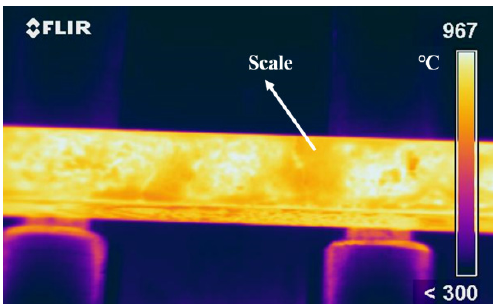
Figure 2. Thermal image of billet during hot rod rolling using an infrared thermo-camera.